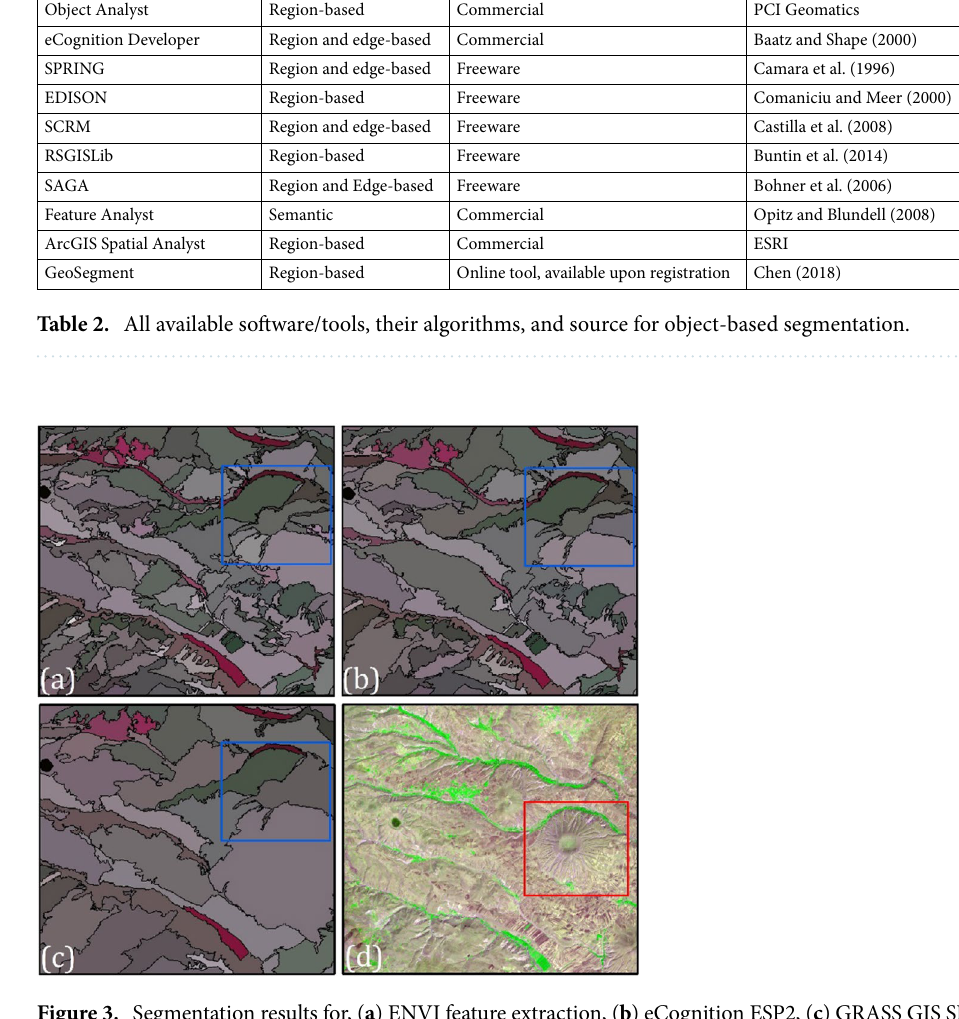
Figure 3. Segmentation results for, ( a ) ENVI feature extraction, ( b ) eCognition ESP2, ( c ) GRASS GIS SPUS PO, and ( d ) original Sentinel-2